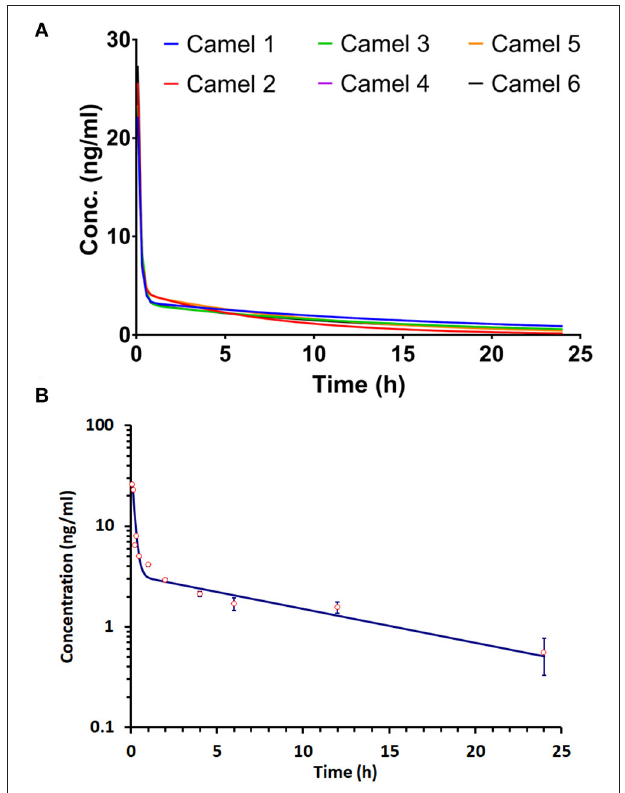
FIGURE 1 | Progression of the acepromazine concentration–time curve after 0.1 mg/kg i.v. administration in Arabian camels ( n = 6). (A) The time–concentration curve progression in individual camels. (B) The mean ± SD of time–concentration values for all